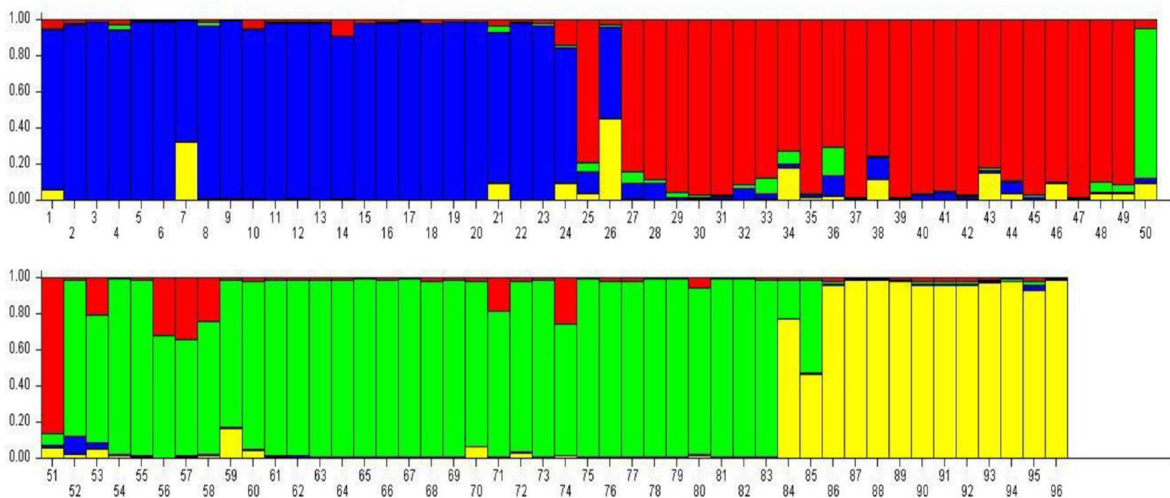
Fig 5. Analysis of substructure of the cauliflower genotypes using STRUCTURE software. Each genotype is represented by a vertical bar, which is partitioned into K colored segments that represent individual’s estimated membership coefficient (Q) to the K (= 4)clusters (STRUCTURE2.3.4). Four subpopulations were G1-Blue, G2-Yellow, G3-Red and G4-Green.